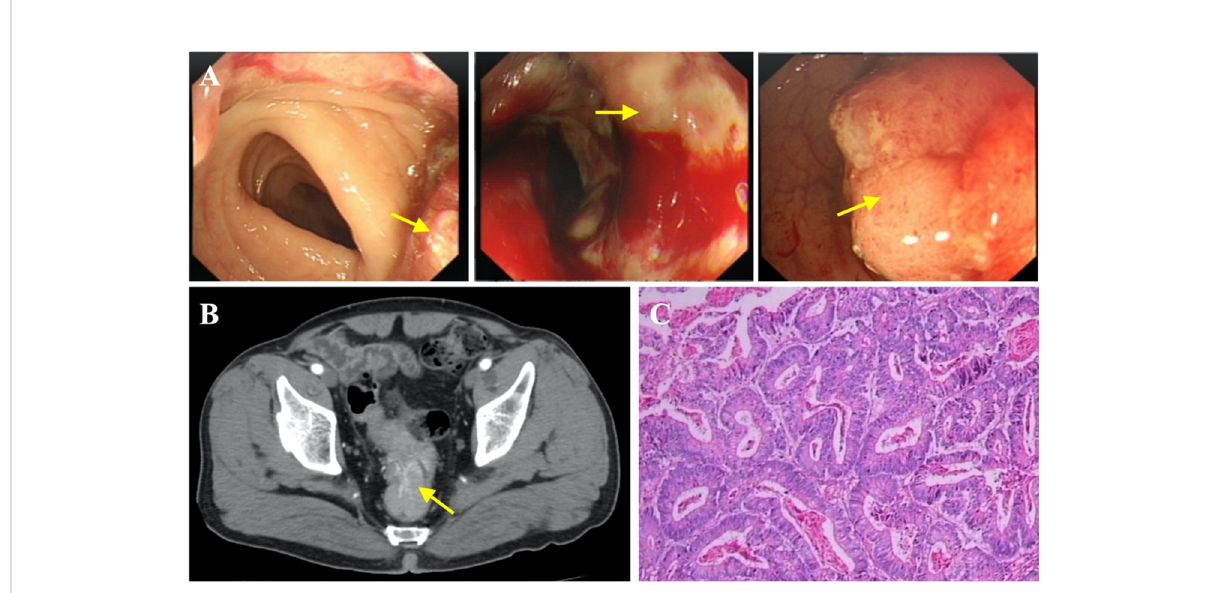
FIGURE 4 Diagnosis of rectal carcinoma. (A) Endoscopic images indicating rectal carcinoma (yellow arrow). (B) Contrast-enhanced CT showing rectal cancer. (C) Representative histopathological image of rectal